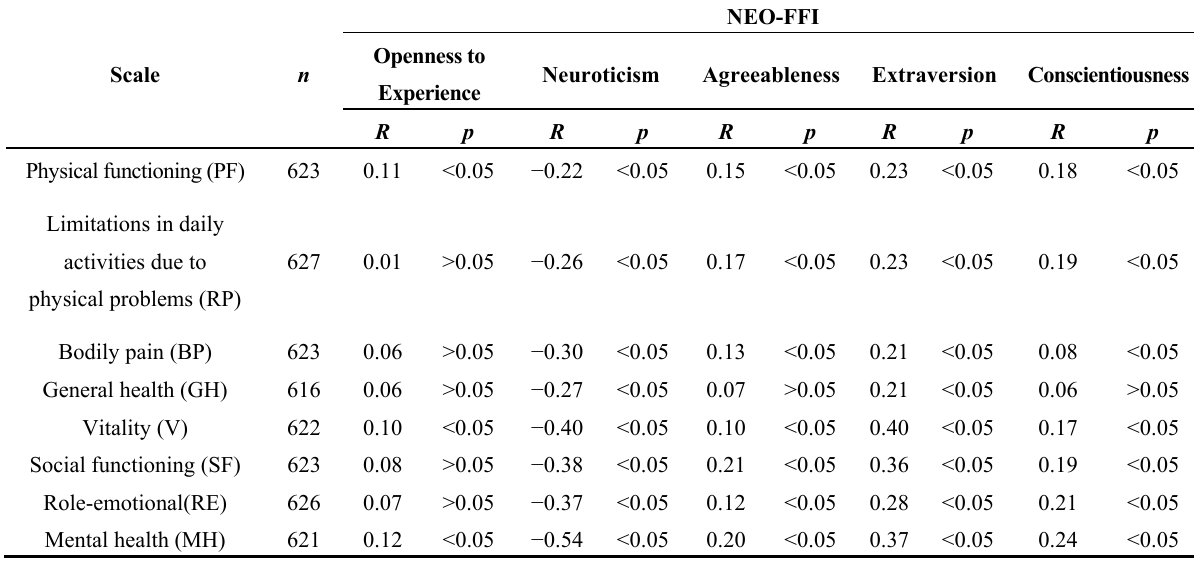
Table 7. Correlations between quality of life according to SF-36 and personality traits according to NEO-FFI.